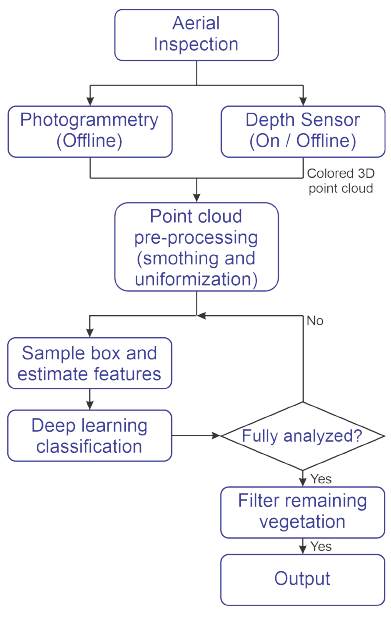
Figure 1. Methodology